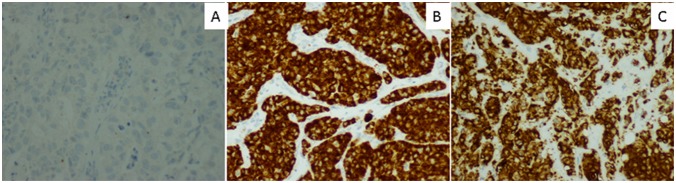
Detection of ALK rearrangements using Ventana immunohistochemistry (IHC) (200×).(A) An ALK-negative case without cytoplasmic staining. (B) An EML4-ALK-positive case with strong granular cytoplasmic staining. (C) A KIF5B-ALK-positive case identified by RT-PCR with strong granular cytoplasmic staining.